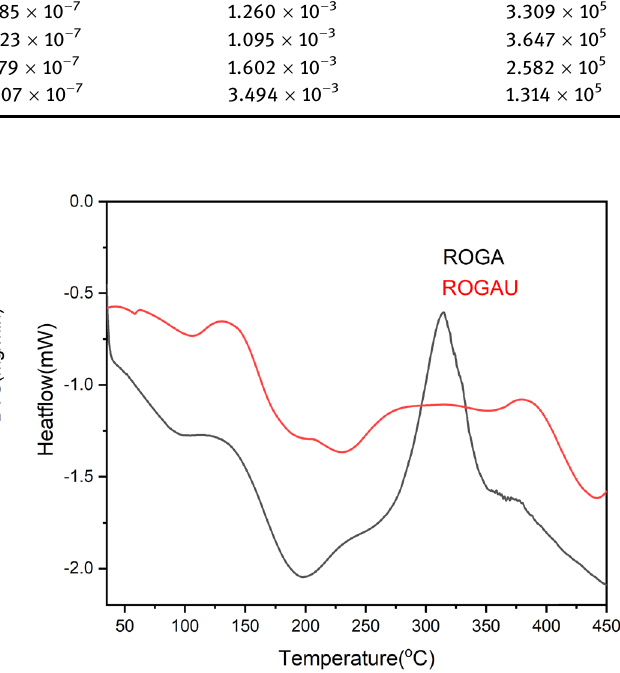
Figure 9: DSC thermogram of ROGA and